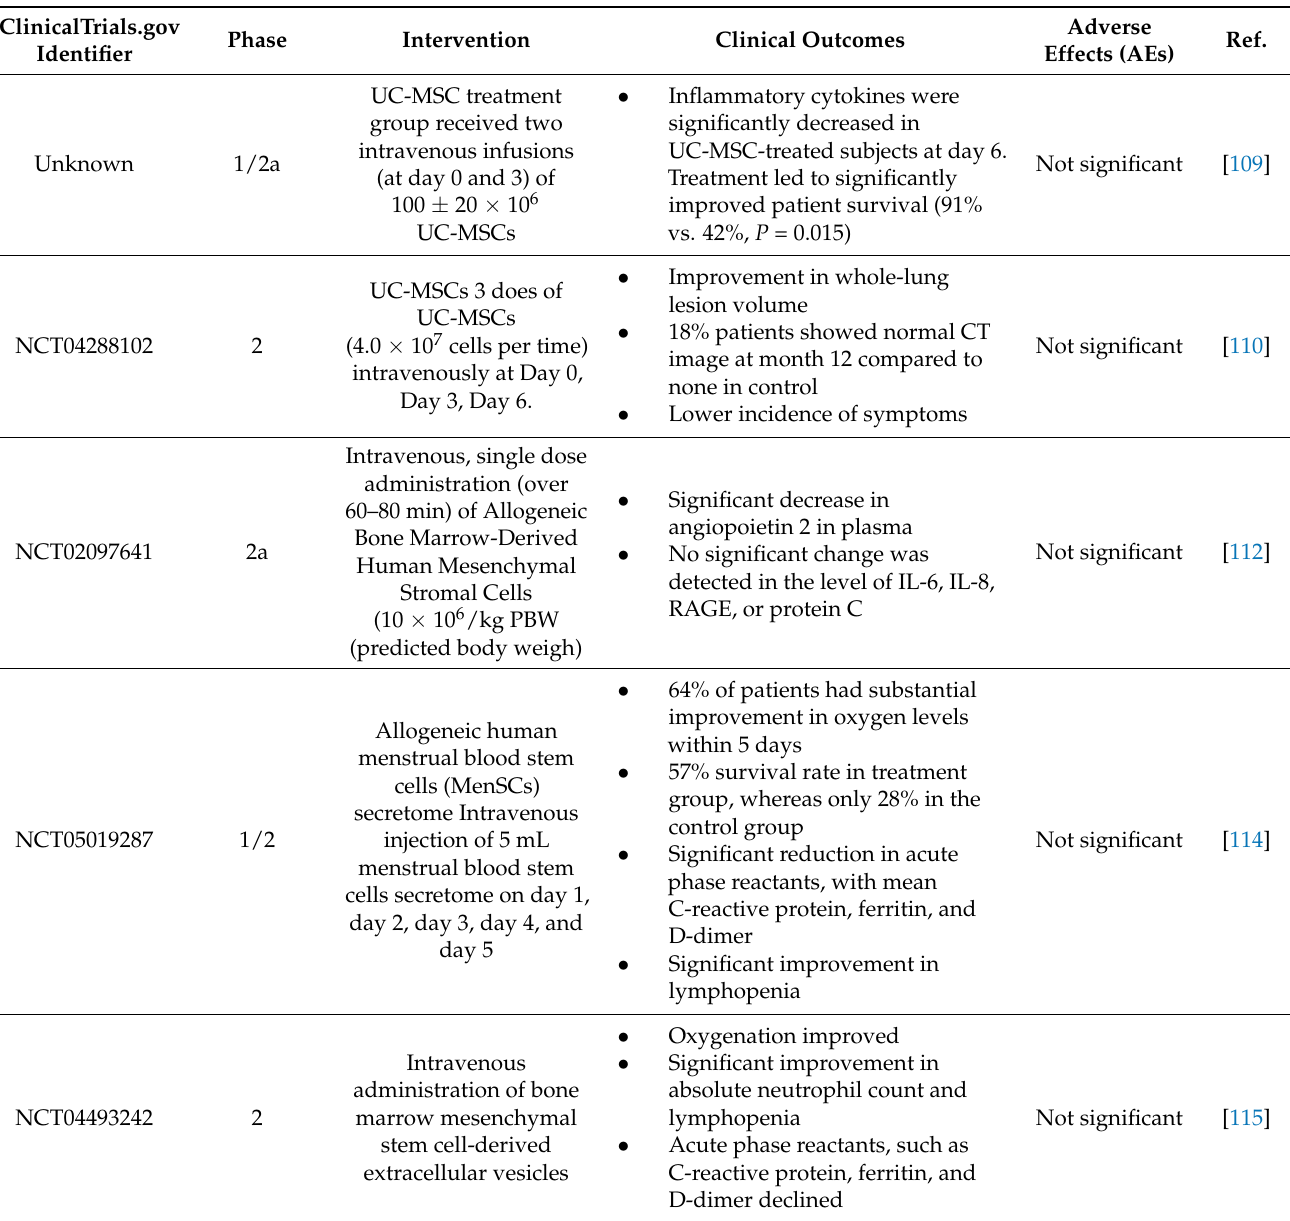
Table 1. Successful clinical trials involving mesenchymal stem cells in serious/critical COVID-19